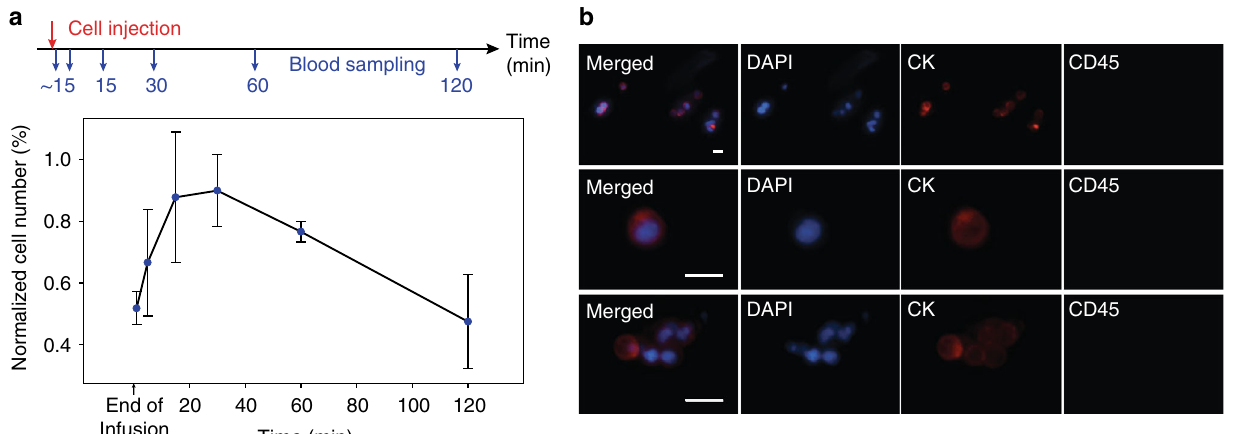
Fig. 3 Cellular kinetics of MCF7 cells after intravenous injection in dogs. a Overview of cell injection followed by venipuncture for blood sampling and ex vivo enumeration with the HB GO chip. Normalized number of MCF7 cells isolated from 1 mL serial blood samples, as a function of time after infusion, were averaged from three separate experiments (data points are means ± s.d., n = 3). b Fluorescent microscope image of MCF7 cells and clusters captured ex vivo. Cells were stained with DAPI (blue), Cytokeratin (red), and CD45 (green). The scale bars represent 25 µ m. Source data are available in the